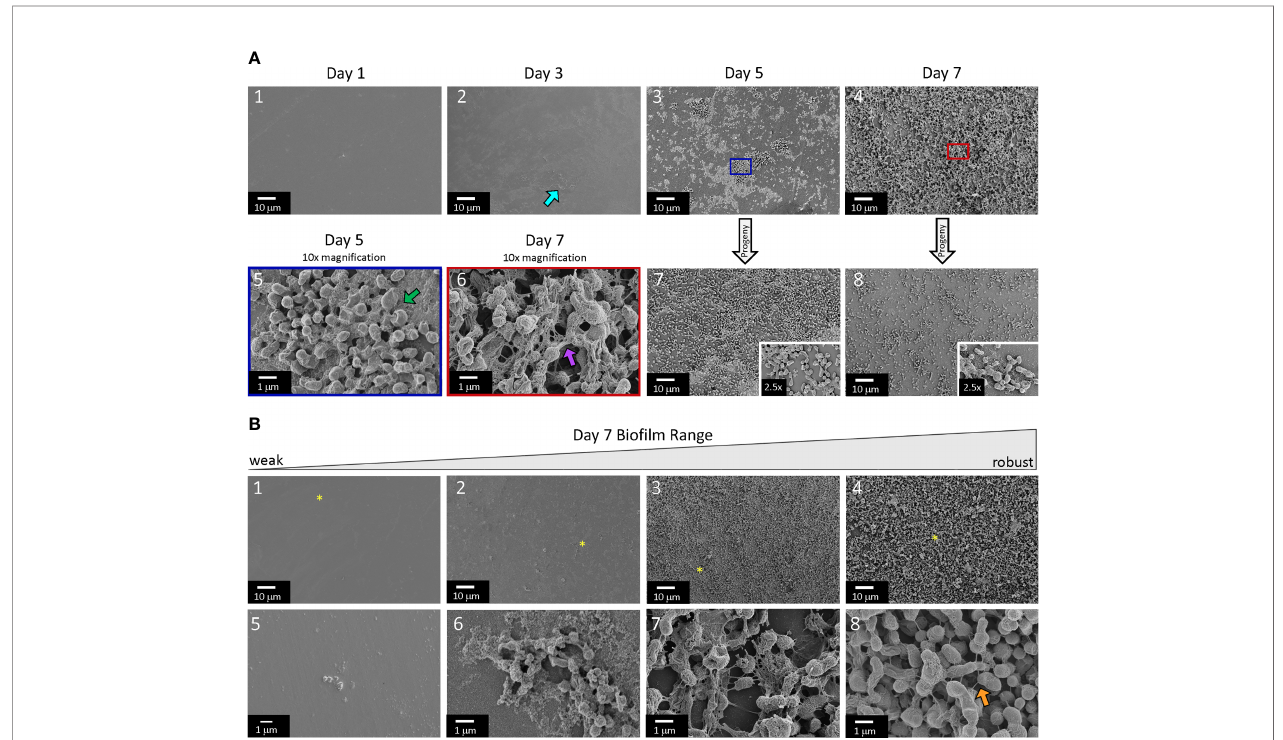
FIGURE 2 | Scanning electron microscopy shows a well-de fi ned extracellular matrix in bio fi lm positive samples. (A) The bio fi lm of LVS bio fi lm was sampled at 1, 3, 5 and 7 days and analyzed by SEM. The blue and red rectangle (day 5 and 7, respectively) highlight the enlarged area. Grey arrows labeled progeny indicate the original samples from which cells were sub-cultured to obtain progeny micrographs. Teal arrow indicates surface depositions. Green arrow indicates a smooth, totally encased bio fi lm. Purple arrow indicates a string-like extracellular matrix. Golden arrow indicates cell to cell projections. (B) Representative images of the range of bio fi lm formation observed in a 7 day culture of LVS. Yellow asterisk (top panel) indicates the area that is enlarged (bottom panel). Images displayed are representative from multiple independent